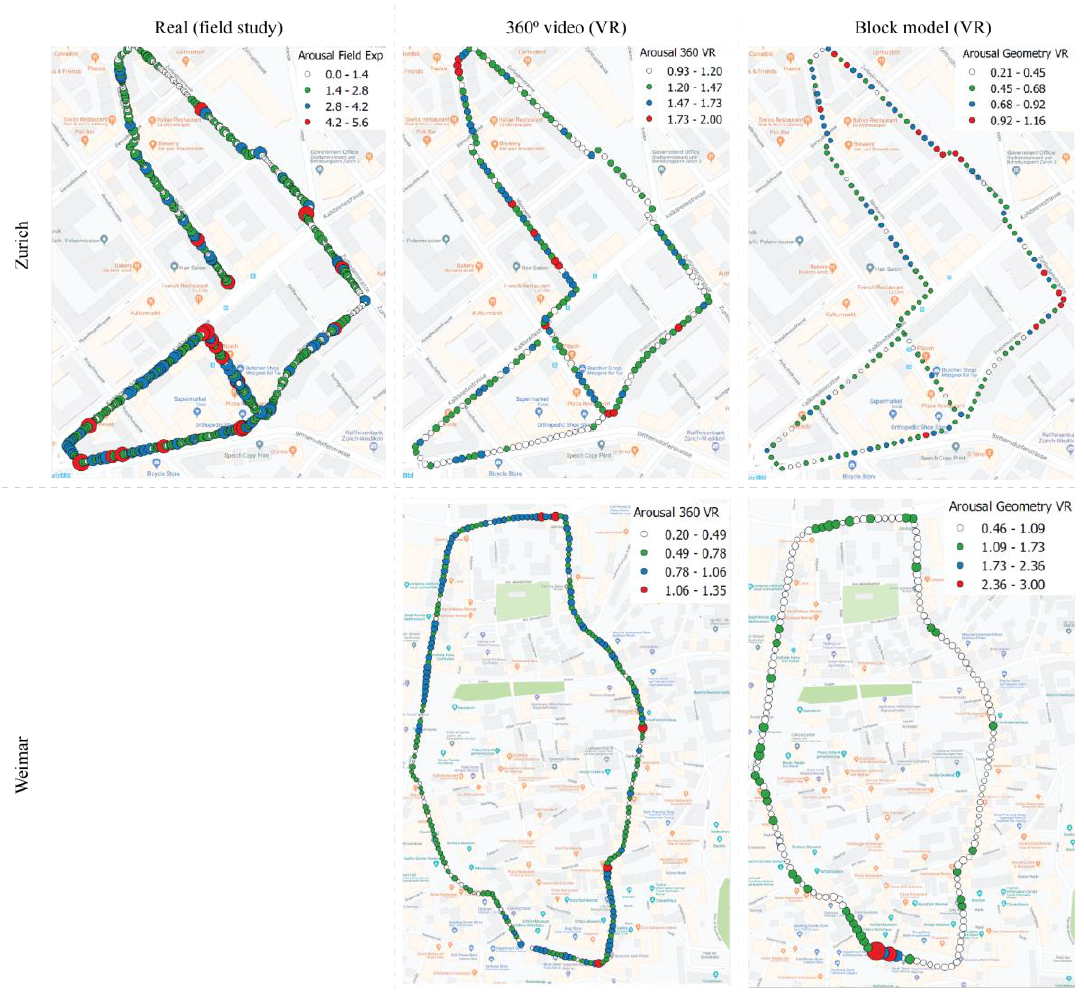
Figure 8. Mapping of arousal peaks from the results of the field study, 360 ◦ -video study, and geometry model study (left to right). Arousal peaks mapped along the two experimental paths. The quantified EDA results are shown with red dots indicating more arousal peaks than the blue and green dot; white indicates a very low number of arousal peaks in the EDA data.